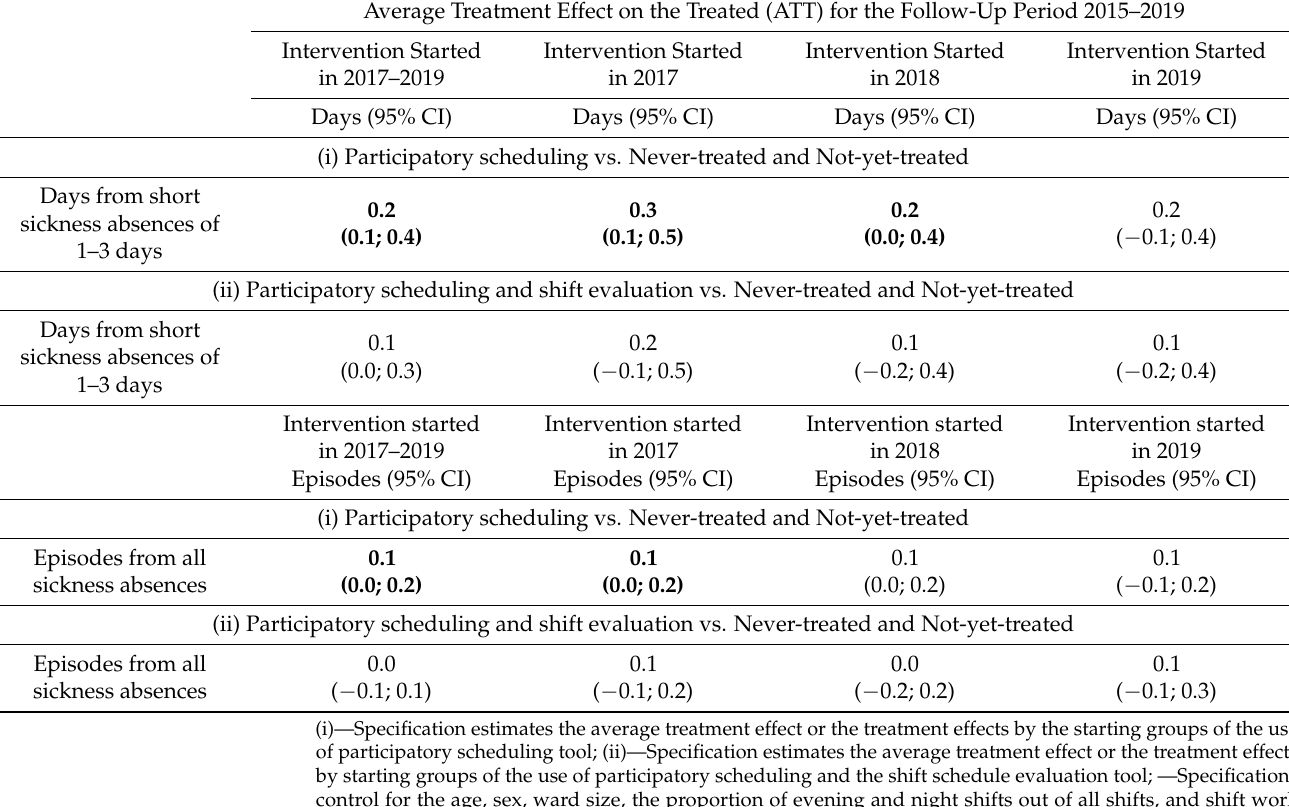
Table A1. The estimated effects of the use of the participatory scheduling tool and the shift schedule evaluation tool on sickness absence days from short absences of 1–3 days and episodes from all absences. Average treatment effects on the treated estimates with ward-level clustered standard errors. Statistically significant differences are bolded.